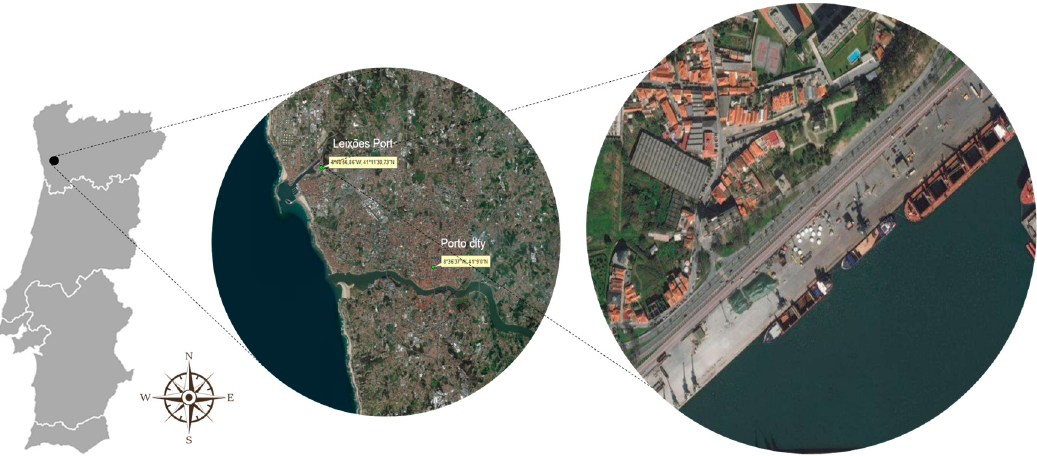
Figure 1. Geographical location of Porto area, Port of Leixões: North region of Portugal. The Port of Leixões is located in the north region of mainland Portugal at 41° 11 ′ N, 8° 40 ′ W.